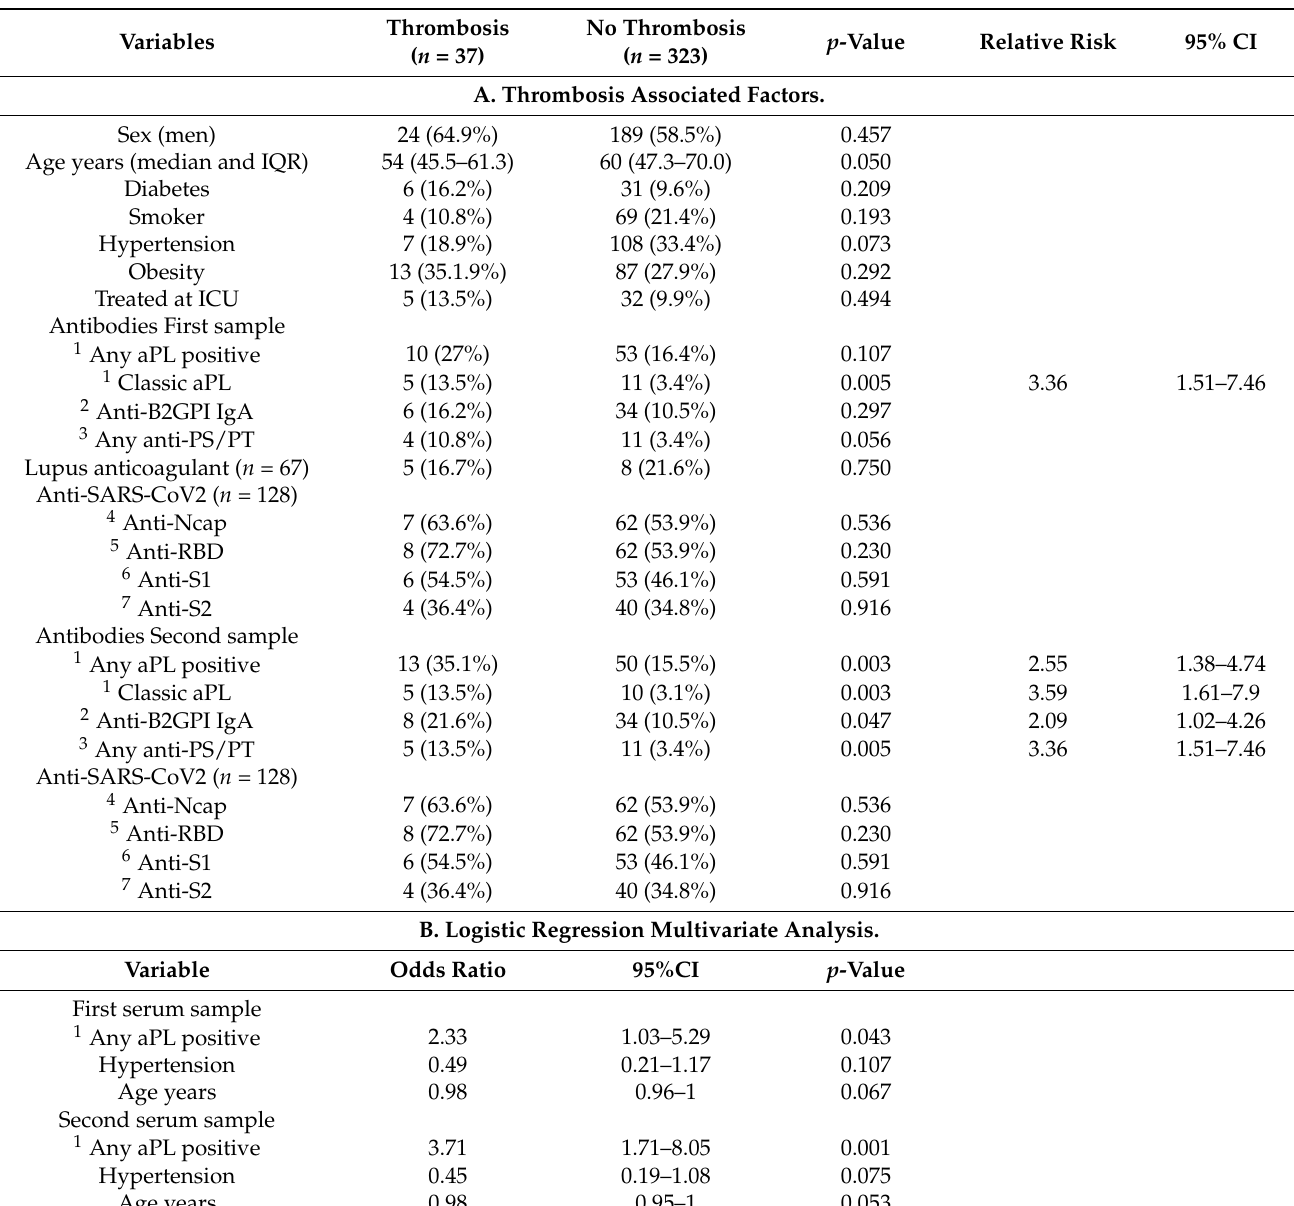
Table 4. Characteristics of the patients who developed thrombotic events during the first six months from the diagnosis of COVID-19. A. Univariate analysis of thrombosis associated factors. B. Multivariate analysis of factors associated to thrombosis events during follow-up (6